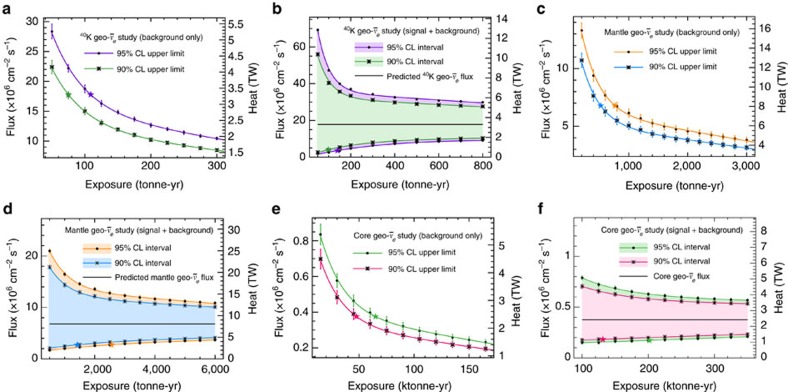
Mean geo-neutrino flux sensitivity at Gran Sasso.Flux sensitivity calculated at Gran Sasso (Italy) and shown here versus exposure for the geo-neutrino flux from: (a,b) potassium (40K) decays; (c,d) the mantle, assuming no radioactivity in the core; and (e,f) the core, assuming 10 p.p.b. uranium and thorium in the core. Error bars denote s.e.m. Each curve has been fit with a line plus exponential. (a,c,e) show the mean 95% (90%) confidence level (CL) upper limits for background-only pseudo-experiments; the star-shaped markers represent the exposures needed to achieve an upper limit equal to the predicted signal flux. (b,d,f) show the mean 95% (90%) confidence interval for signal+background pseudo-experiments; the star-shaped markers represent the exposures at which 95% (90%) of pseudo-experiments have a non-zero lower limit. A CF4 target and angular resolution given by equation (1) have been assumed, with an applied electron energy threshold of T>(a,b) 200 keV, (c,d) 250 keV or (e,f) 800 keV.